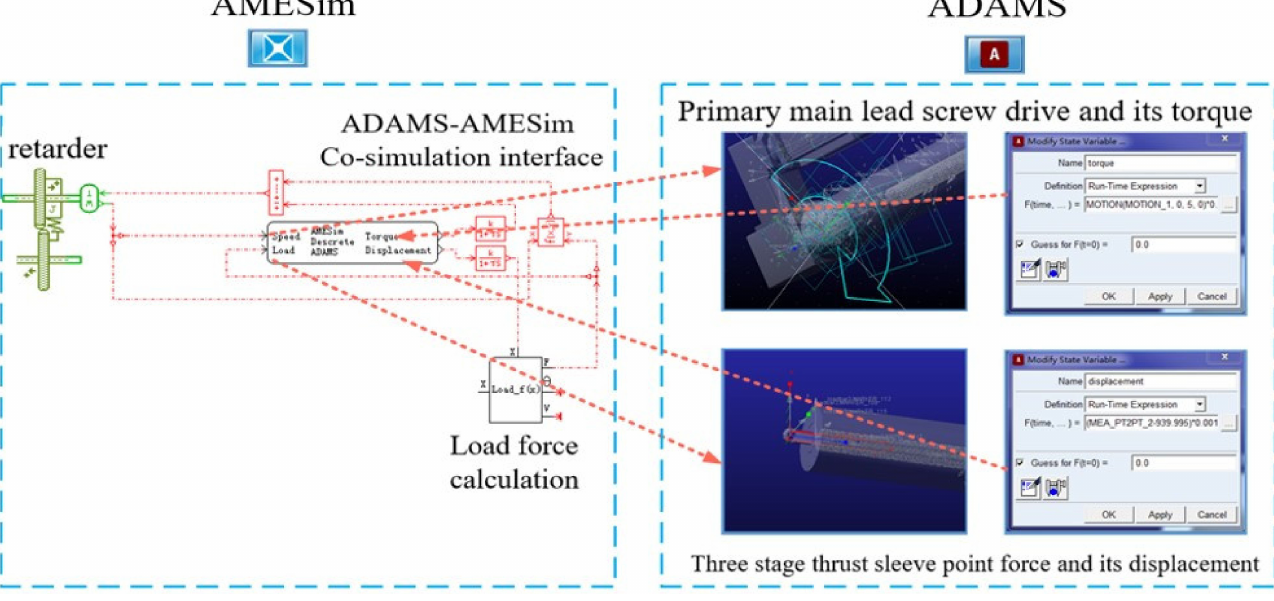
Figure 10. Parameter transfer relationship between AMESim and